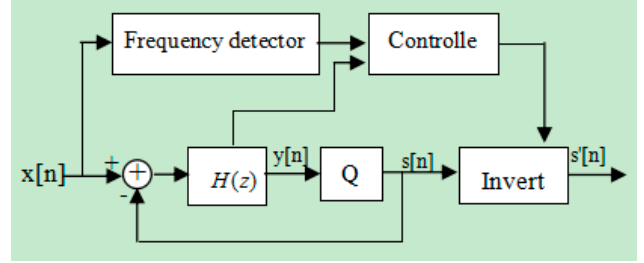
Figure 1. Block diagram of the proposed system.